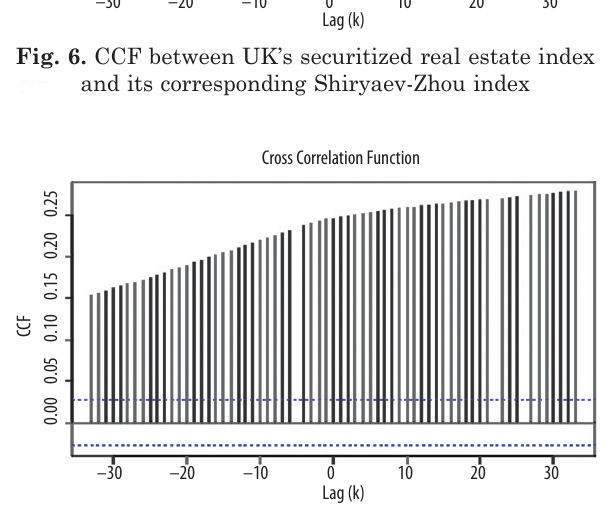
Fig. 7. CCF between Canada’s securitized real estate index and its corresponding Shiryaev-Zhou index